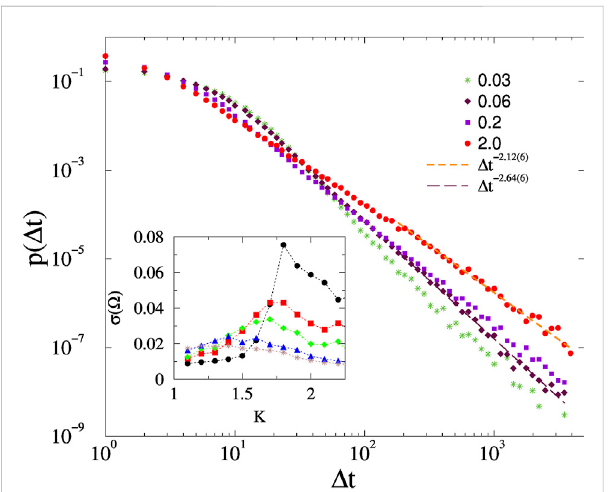
FIGURE 5 Avalanche duration distributions on the KKI-113 connectome for different forces, shown by the legends and at K = 1, ϵ = 0.01. Dashed linesarePL fi tsfor Δ t > 20.The F =0.1caseveersdownonthelog.-log. scale, but for F = 0.35 a more extended PL tail with exponent τ t =